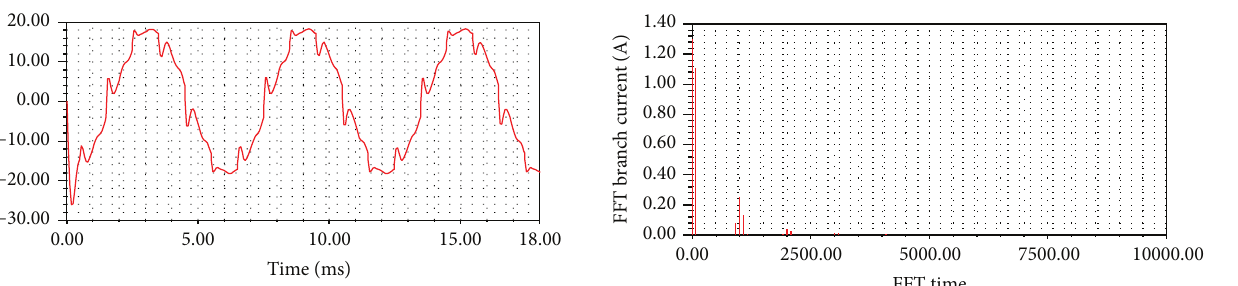
Figure17:TheFFTofDClinkcurrent(withLCLfilterandcapacitor bank).